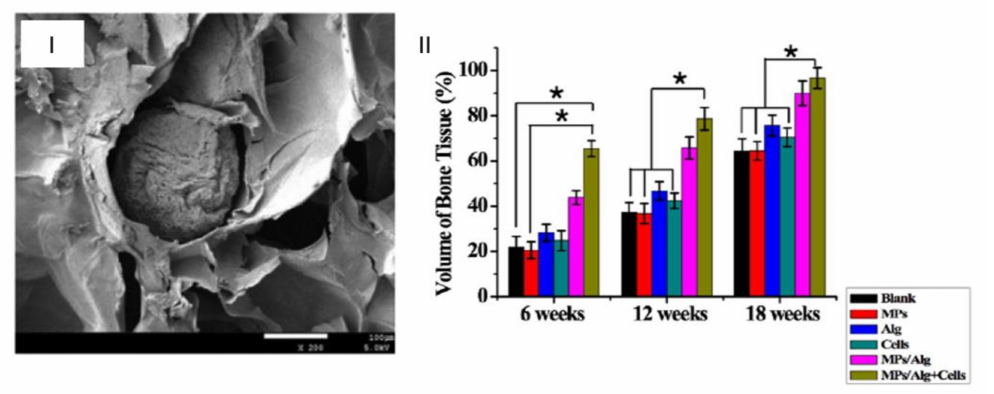
Figure 11. ( I ) SEM image of a cross section of porous microparticles within an alginate hydrogel (scale at 100 µ m); ( II ) volume of newly formed bone tissue in vivo in different groups 6, 12, and 18 weeks after operation (* p < 0.05). (Adapted with permission from [70]. Copyright (2021) American Chemical